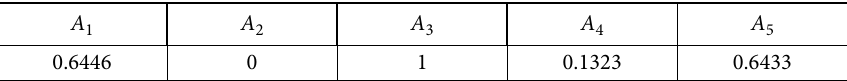
Table 12. The normalized appraisal scores of the enhancement EDAS method based on the PT 1